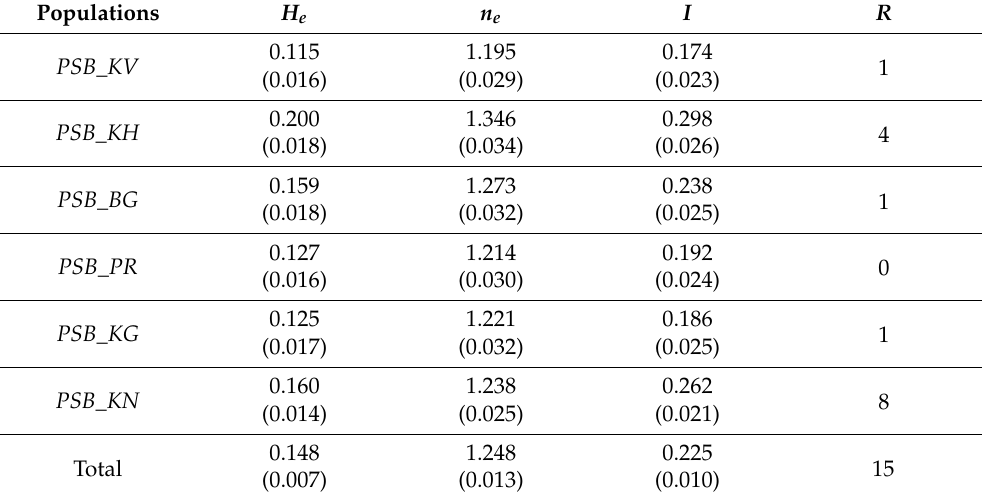
Table 3. Genetic diversity of the studied populations of P. sibirica .